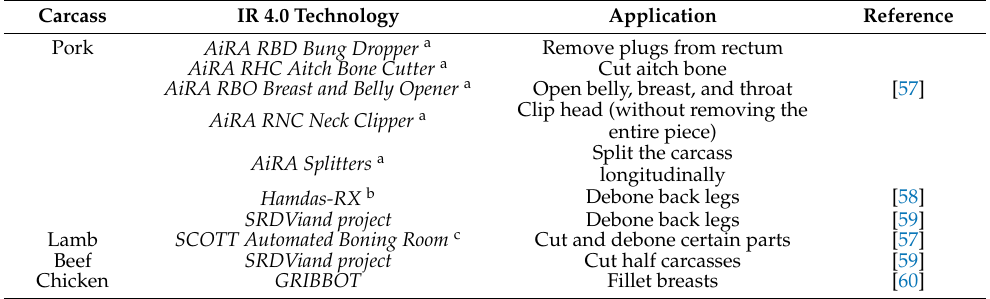
Table 1. Automation and robotization of the primary and secondary processing of various carcasses in the meat